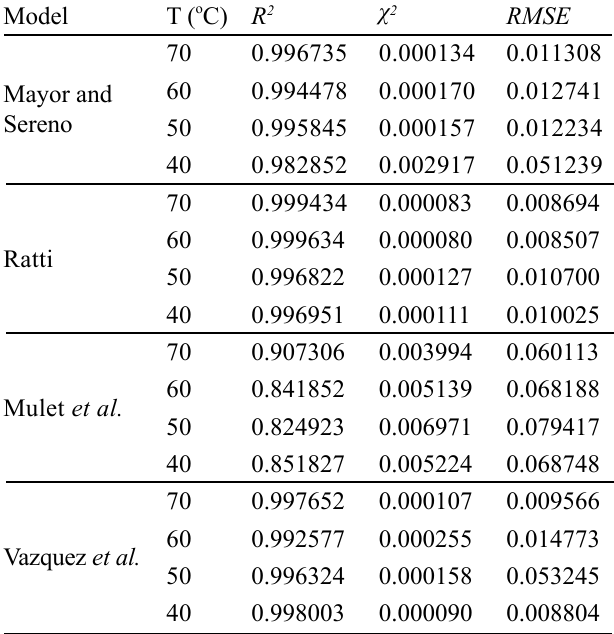
Table 6. Statistical results of mathematical models fitting for hawthorn shrinkage at different drying air temperatures